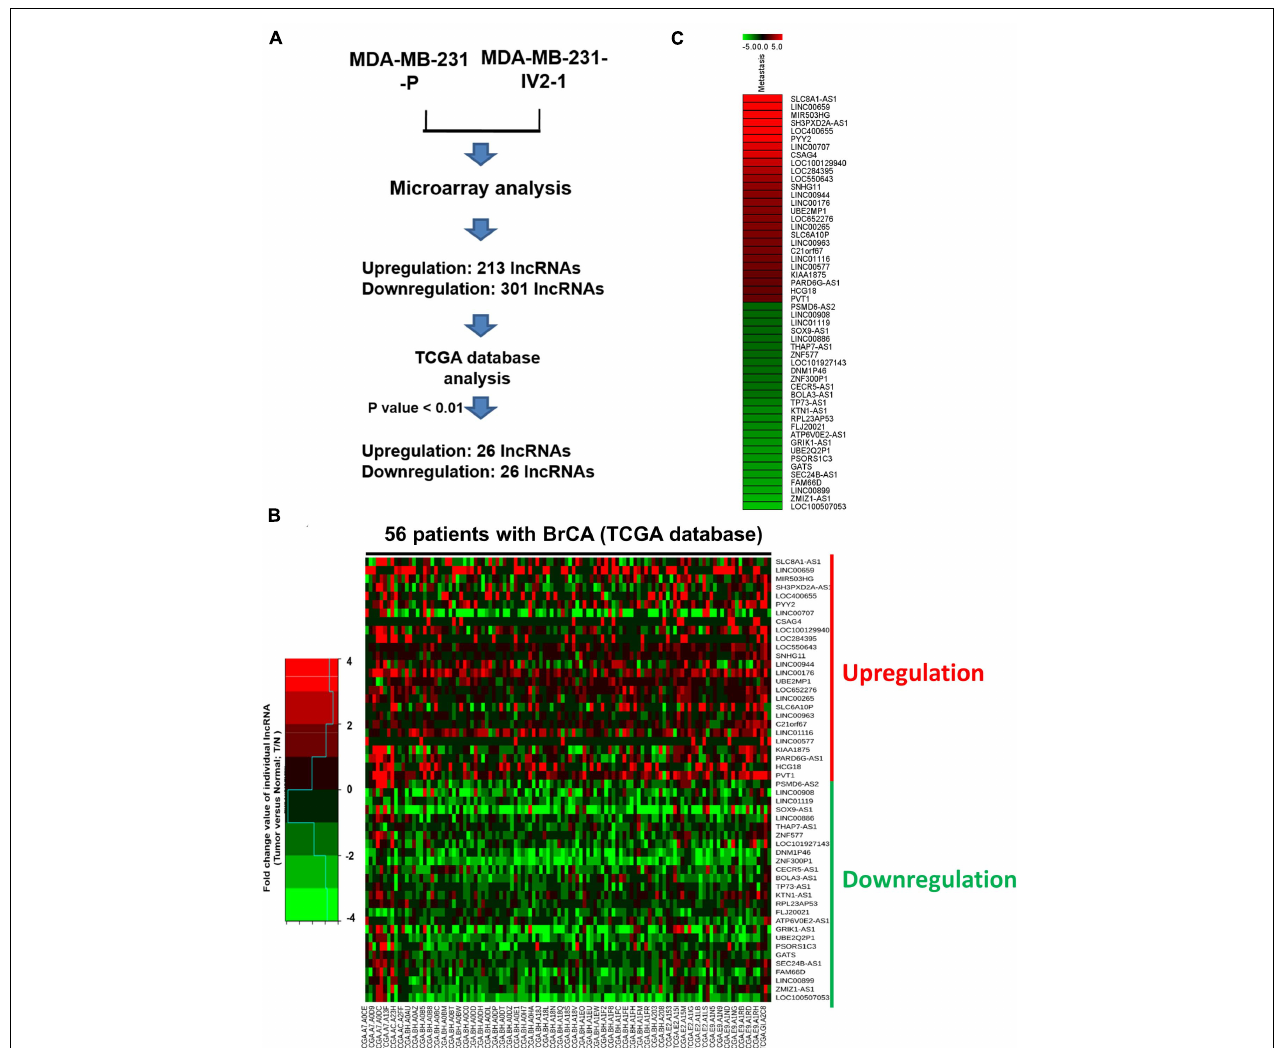
FIGURE 1 | Comparison of MDA-MB-231-P and MDA-MB-231-IV2-1 lncRNA profiles. (A) Flowchart for the microarray approach to screening lncRNA candidates and the use of TCGA database to examine their expression levels. (B) The 56 expression profiles of normal/tumor tissue pairs from patients with breast cancer obtained from TCGA database. The fold change values of the individual lncRNAs were calculated using the lncRNA expression levels of tumor cells compared with non-tumor cells. A heatmap of the differential expression of the 52 lncRNA candidates in 56 patients with breast cancer is presented. (C) Heatmap of selected putative metastasis-associated lncRNAs in MDA-MB-231-P cells compared with MDA-MB-IV2-1